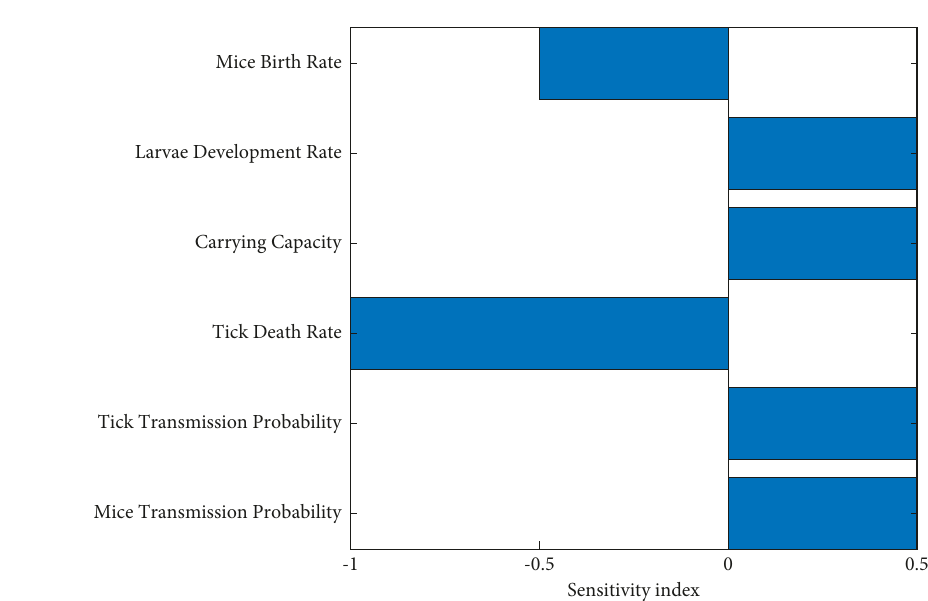
. The mice birth rate and tick death rate are negative 0